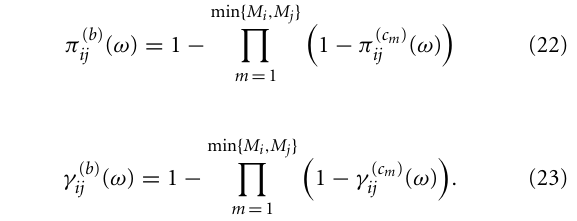
By adopting time series blocks as X 1 = [ Y 1 Y 2 ] and X 2 = [ Y ] , when e = f = g = h = 0, direct computation shows that 3 Y 4 the canonical PDC from block X 2 to X 1 is zero, i.e., π ( c 1 )